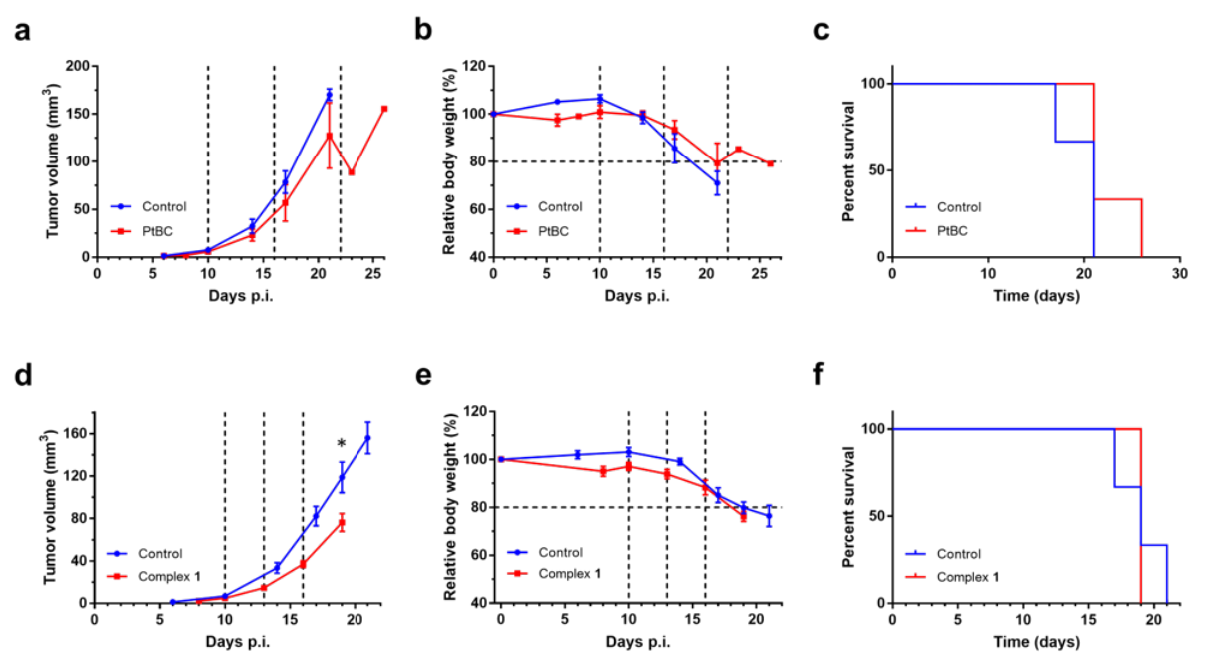
Figure 4. In vivo efficacy evaluation in two treatment schedules at different time post injection (p.i.). ( a – c ) Every-6-days IMS for GL261 GB therapy in mice. Complex 1 was administered every 6 days, and tumor volumes were measured by high-resolution T2w MRI twice per week. ( a ) Tumor volume evolution of mice from control ( n = 7) and complex 1 group (1.5 mg Pt/kg) ( n = 3). ( b ) Evolution of body weights of mice on IMS schedule from all groups. ( c ) Kaplan-Meier survival curves of all groups. ( d – f ) Intensive treatment for GL261 GB therapy in mice. complex 1 was IN-administered every 3 days, and tumor volumes were acquired by high-resolution T2w MRI twice per week. ( d ) Tumor volume evolution of mice from control ( n = 7) and complex 1 group (1.5 mg Pt/kg) ( n = 6). ( e ) Body weight evolution of mice during treatment. ( f ) Kaplan-Meier survival curves of all groups. Vertical dash lines indicate the days of therapy administration. Horizontal dash line indicates the 20% weight reduction point, below which the mice had to be euthanized. Data represent mean ± SE. * stands for p < 0.05.